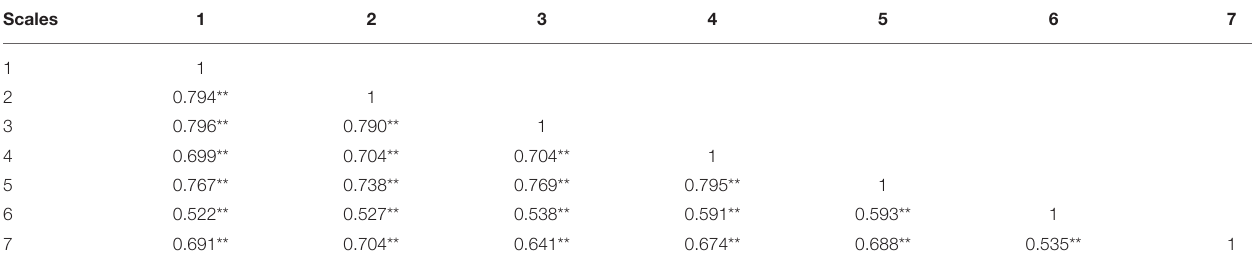
TABLE 3 | Spearman’s correlations of psychological outcomes.